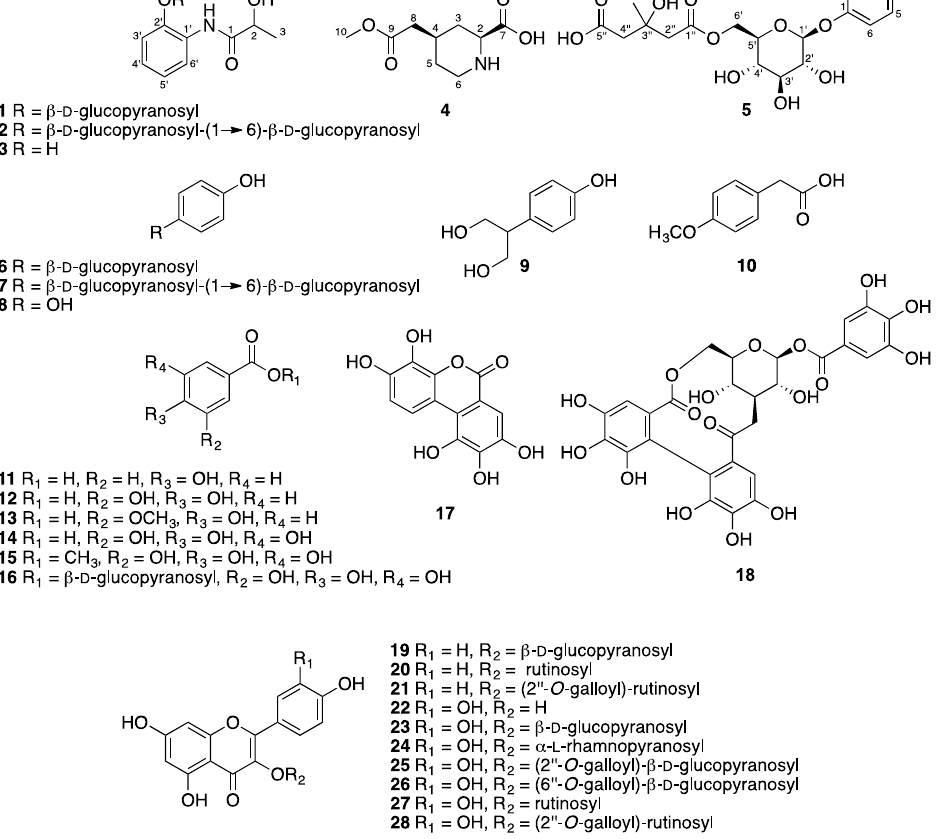
Figure 1. Chemical structures of 1 – 28 .